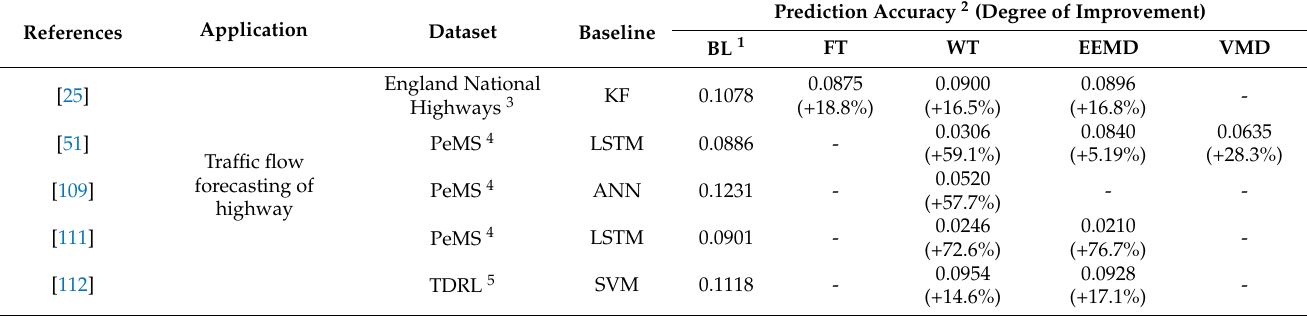
Table 4. Degree of performance